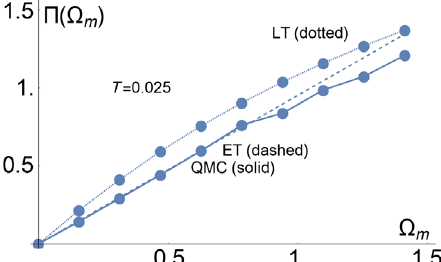
Þ in the spin-fermion model FIG. 7. Bosonic self-energy Π ð Ω m for q ¼ 0 . In this figure, the dashed trace corresponds to the T ¼ 0 (ET) expression, Eq. (20). Error bars on the QMC data in this and subsequent figures are smaller than the data point sizes.